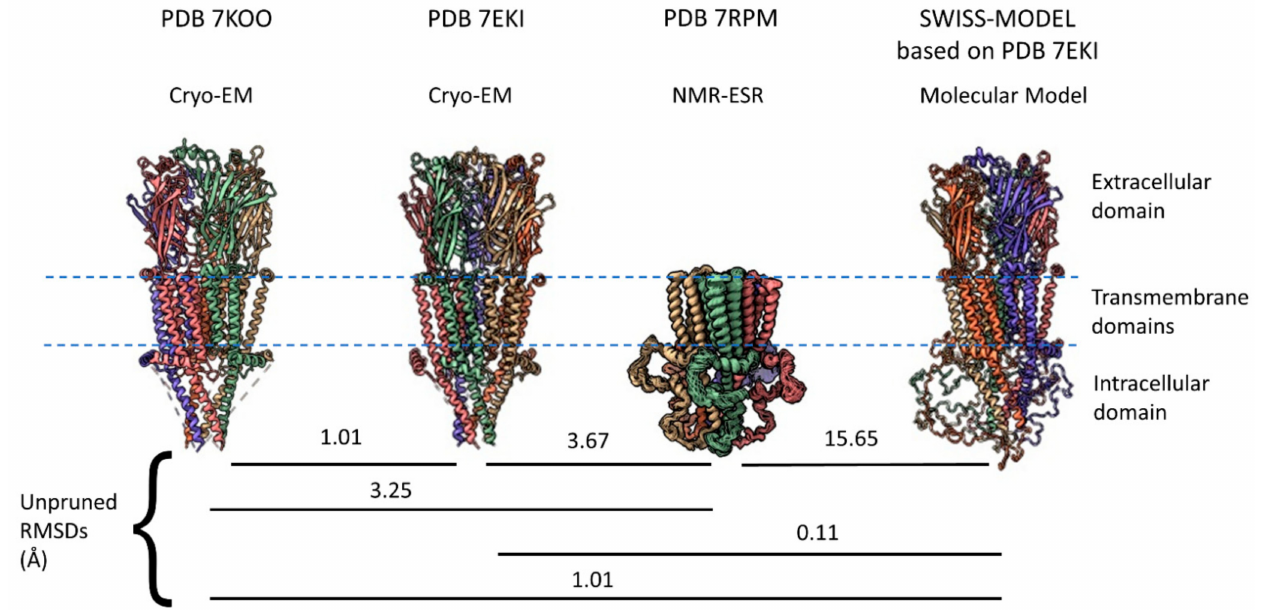
Figure 1. Four views of the human α 7 nAChR structure as ribbon models. PDBs 7KOO and 7EKI are structures determined by cryo-EM and are missing major portions of their ICDs (dotted